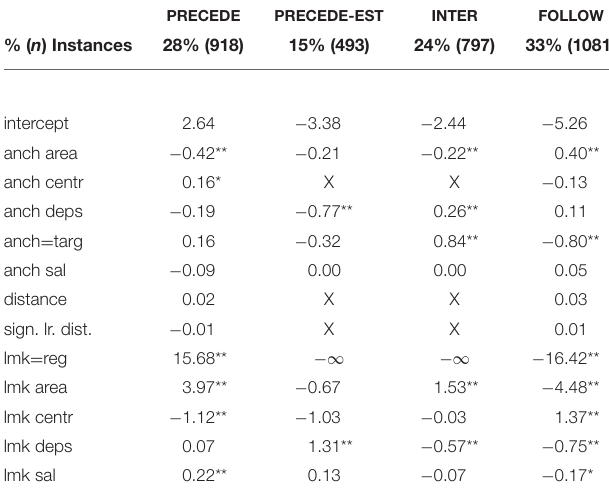
TABLE 1 | One-vs.-all regression effects predicting order of anchor and landmark in relative